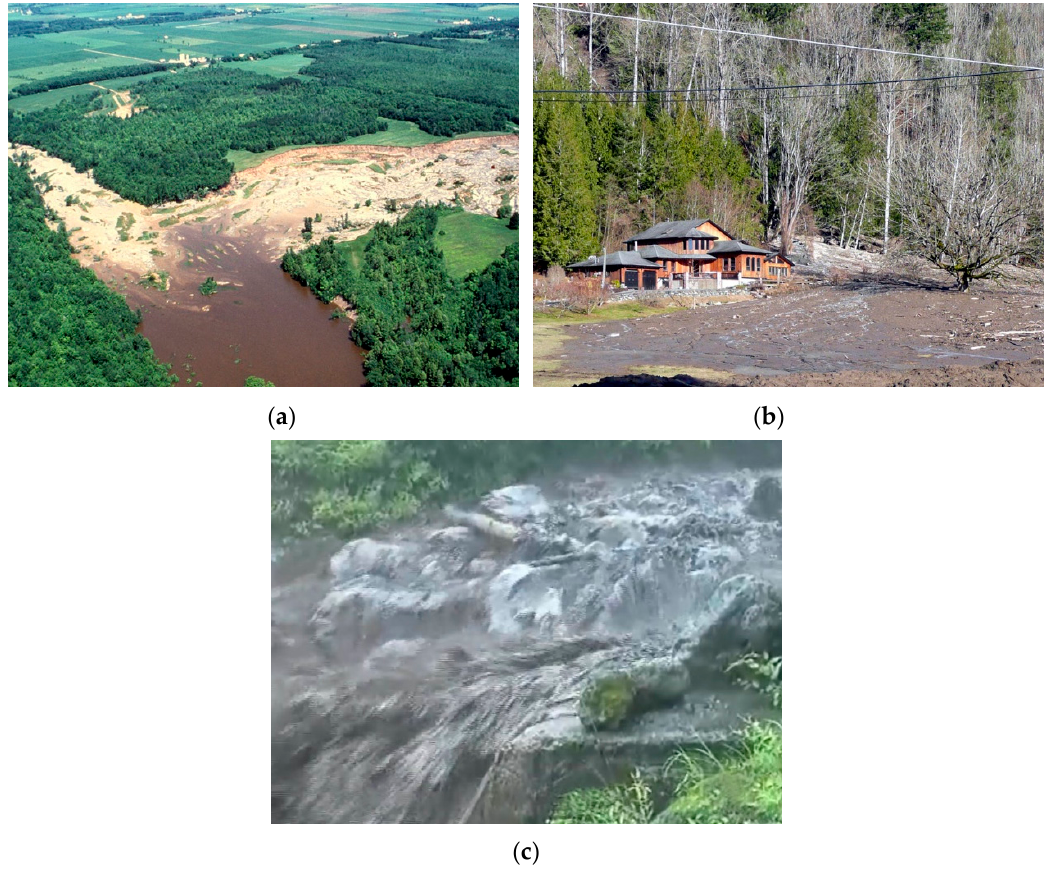
Figure 2. The photos of water-flood, debris-flood and debris-flow processes [47]. ( a ) Water-flood (Evans, S.G.); ( b ) Debris-flood (Hungr, O.); and, ( c ) Debris-flow (Suwa, H.).